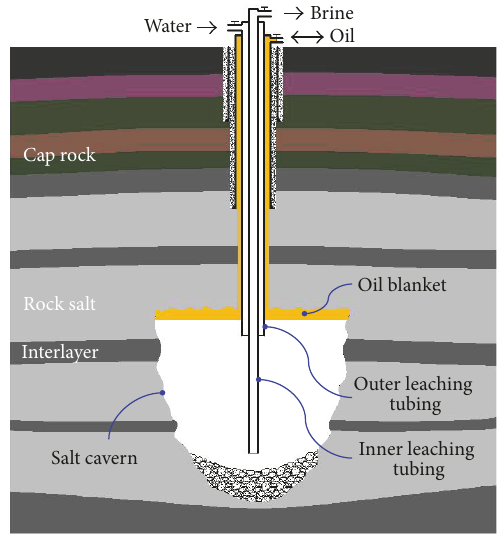
Figure 6: Suggested construction technology of salt cavern oil